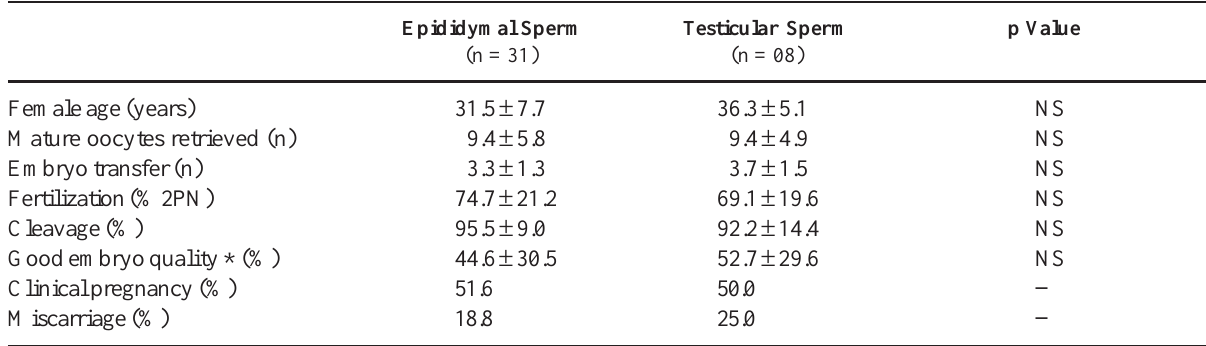
Fisher exact test was used to compare clinical and laboratorial parameters between groups. Clinical pregnancy and miscarriage rates were not compared due to the insufficient sample size. P < 0.05 considered significant; NS = not significant; * = 7-9 blastomeres of similar size, and grades I or II cytoplasmic fragmentation on the day of embryo transfer (day 3) (17). OA: obstructive azoospermia, values are mean ± standard